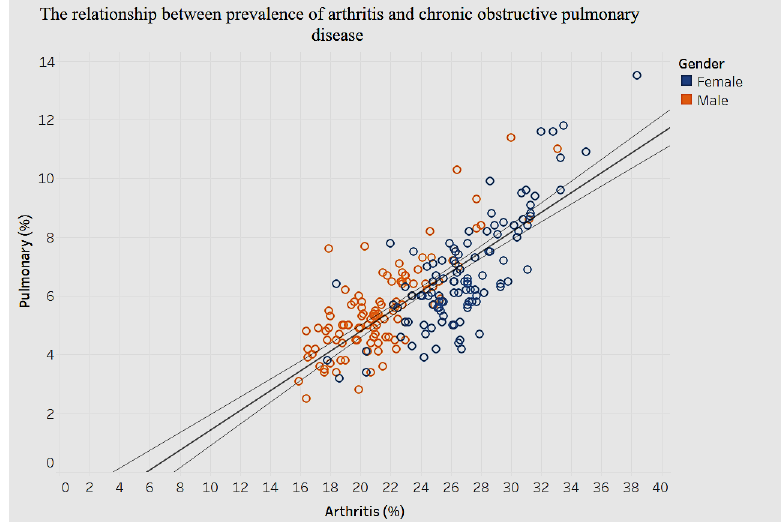
Figure 27. Arthritis by chronic obstructive pulmonary disease.